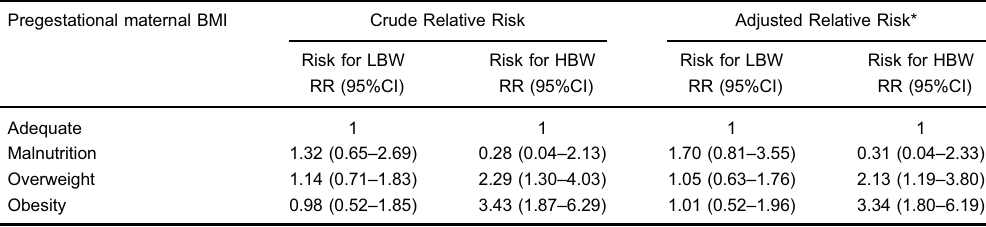
Table 4. Crude and adjusted relative risks of low weight and high birth weight according to maternal pregestational BMI. Ribeirão Preto, 2010. Pregestational maternal BMI Crude Relative Risk Adjusted Relative Risk*